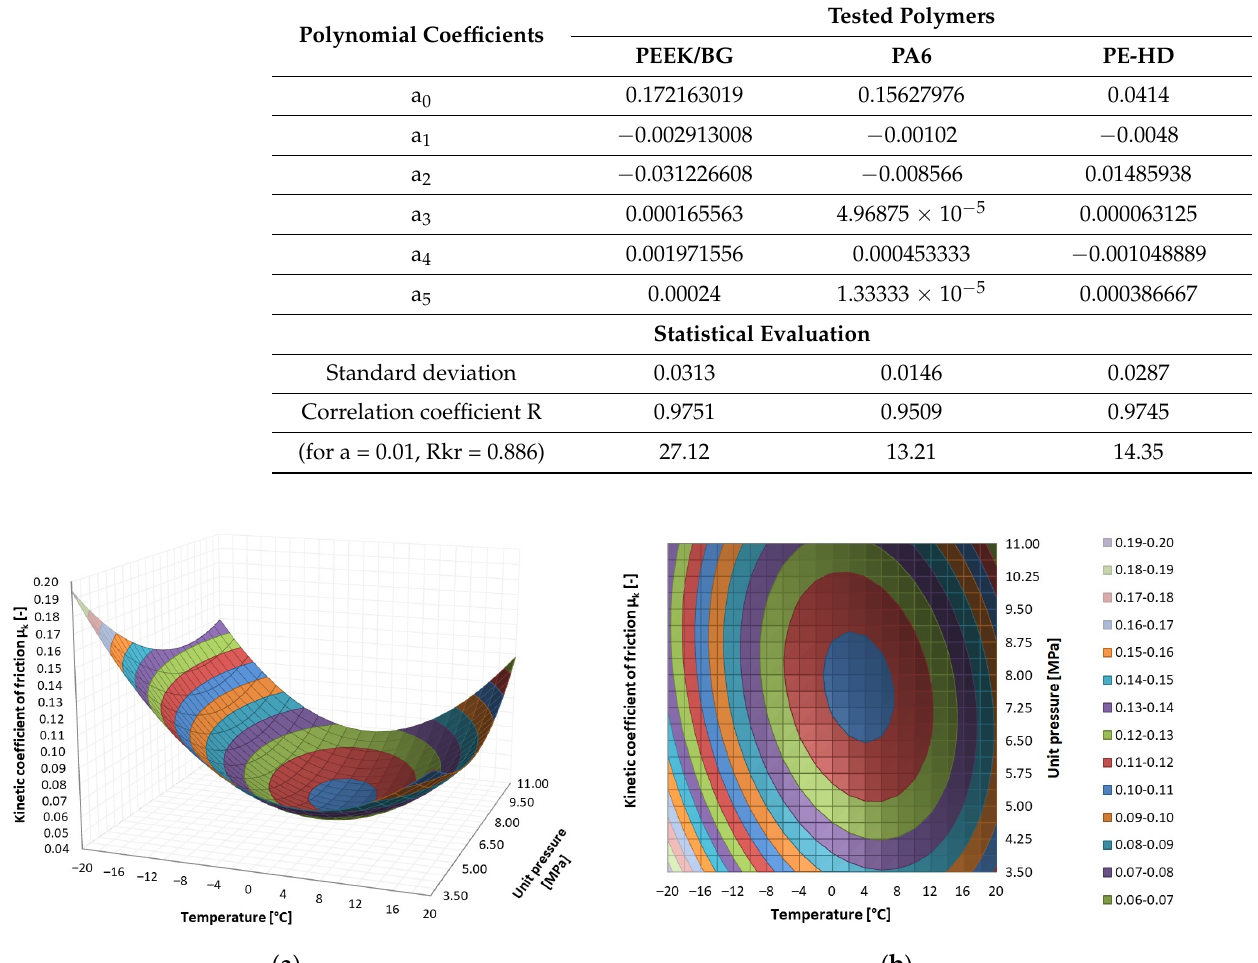
Figure 5. Dependence of kinetic friction coefficient μ k on temperature and contact pressure for PEEK/BG: ( a ) surface graph, ( b ) area graph .